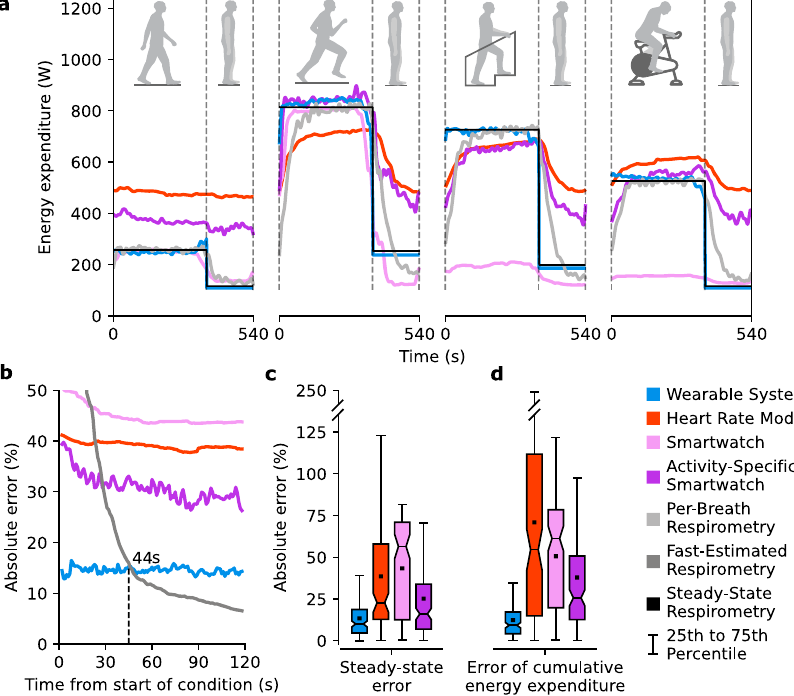
Fig. 2 Estimating energy expenditure during steady-state conditions. a Methods estimating energy expenditure were evaluated during 6-minute steady- state conditions followed by 3 mins of quiet standing. Two conditions were collected for each activity in a randomized order. The estimates were interpolated at 1 s intervals, averaged over subjects, and low-pass fi ltered. b The error as a function of time from the start of the condition evaluated how quickly the methods reached a steady-state estimate, averaged across all conditions. The absolute percent error was computed by taking the mean absolute error between the estimates and ground truth Steady-State Respirometry. c The steady-state error represents the mean absolute percent error between the estimates of each method averaged over the last 3 mins of a condition and Steady-State Respirometry ( n = 24 subjects). Per-Breath Respirometry and Fast-Estimated Respirometry were not compared because they become Steady-State Respirometry when averaged over multiple minutes. d Cumulative energy expenditure is the total expenditure during each steady-state condition, including expenditure above quiet standing during the 3 mins following the condition ( n = 24 subjects). The cumulative error represents the mean absolute percent error between cumulative estimates for each method and Per-Breath Respirometry. The boxes extend from the lower to upper quartile values of the data, with a line at the median and a dot at the mean. The whiskers extend to the last data point within 2.5 times the interquartile range. Fliers were not plotted due to the wide range of